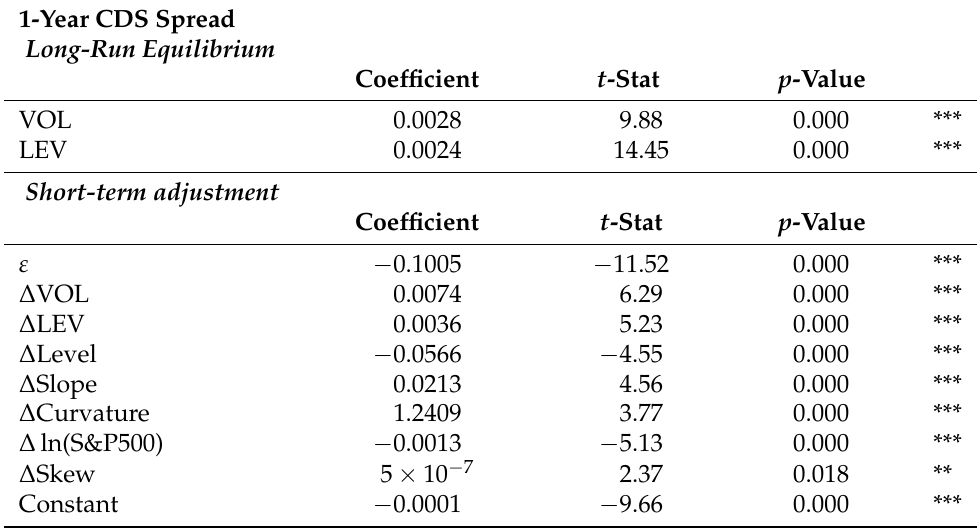
Table 6. ECM for 1-year CDS spreads. All the variables which structural models predict to influence the change in spreads are statistically significant and have the predicted signs. The loading on the cointegrating equation ( ε ) is negative and statistically significant, thus confirming the existence of a long-term equilibrium to which spreads, volatility and leverage converge. This model constrains the long-run coefficient vector to be equal across panels while allowing for group-specific short-run and adjustment coefficients. The averaged short-run parameter estimates are reported.